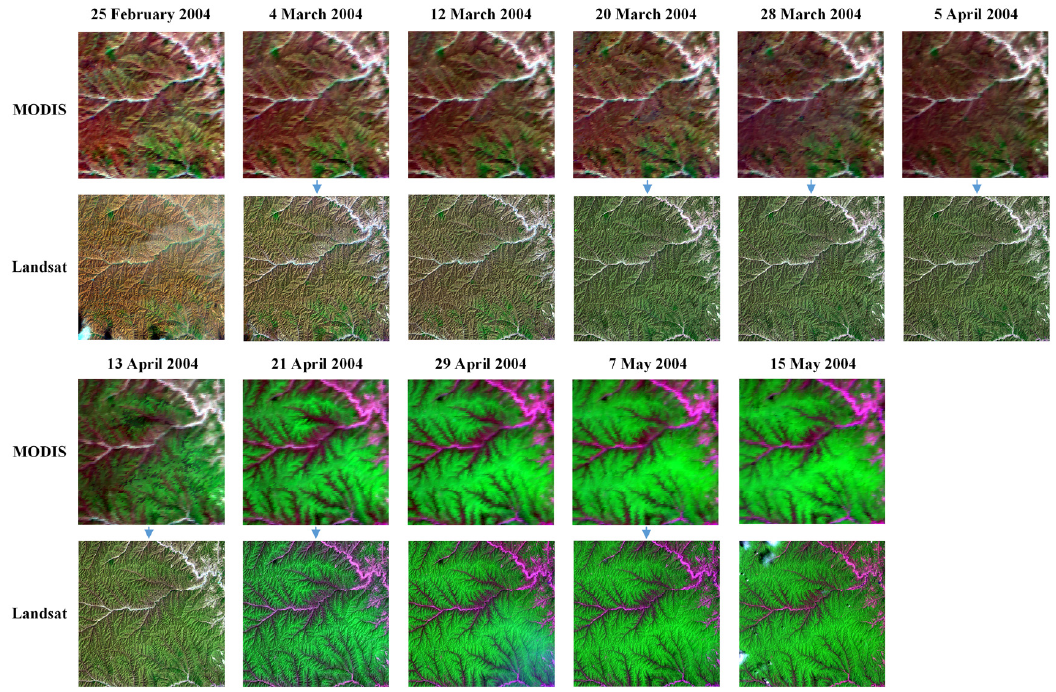
Figure 10. MODIS and Landsat data time series from 25 February to 15 May 2004 in the ZWL region. TM images were shown using the 7-4-2 band combination, and MODIS images were shown using the 7-2-4 band combination. The blue arrow between MODIS and Landsat represented that the corresponding Landsat data were reconstructed, rather than the observed reference image.